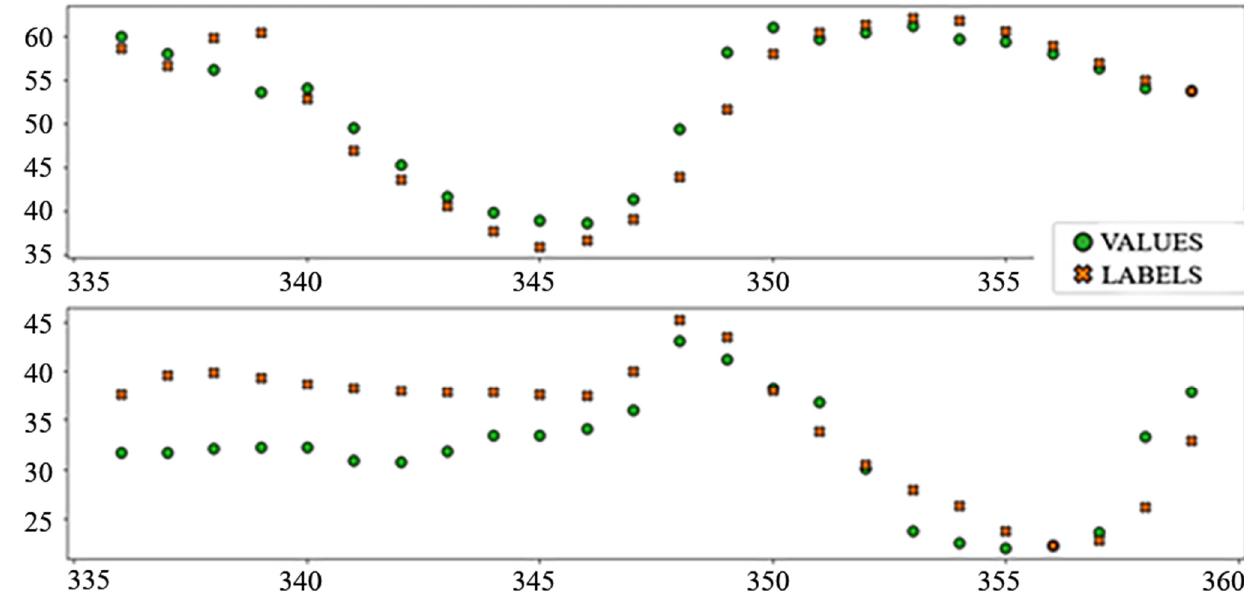
Figure 9. Price prediction: benchmark model “Linear”.